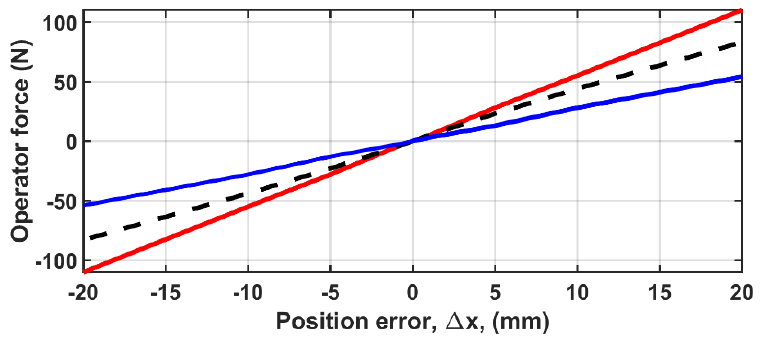
Figure 8. Diagram of correlation between the operator force and a load position error Δ x : red line for L 0 = 1.5 m; dashed line for L 0 = 2.0 m; blue line for L 0 = 3.0 m.